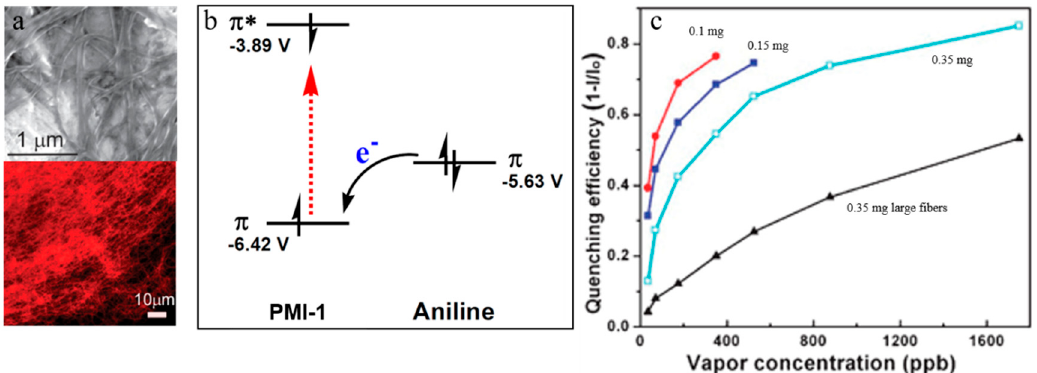
Figure 5. ( a ) SEM image and fluorescence microscopy image of the PMI-1 nanofibers deposited on a glass slide; ( b ) Energy levels of HOMO ( π ) and LUMO ( π *) orbitals of PMI-1 and aniline showing the thermodynamically favorable PET process for fluorescence quenching; ( c ) Fluorescence quenching efficiency (1-I/I o ) measured for the PMI-1 film (deposited from different amounts of nanofibers) as a function of the vapor concentration of aniline [62]; also included for comparison are the corresponding sensor data measured for the larger PMI-1 fibers as reported in another paper [21].